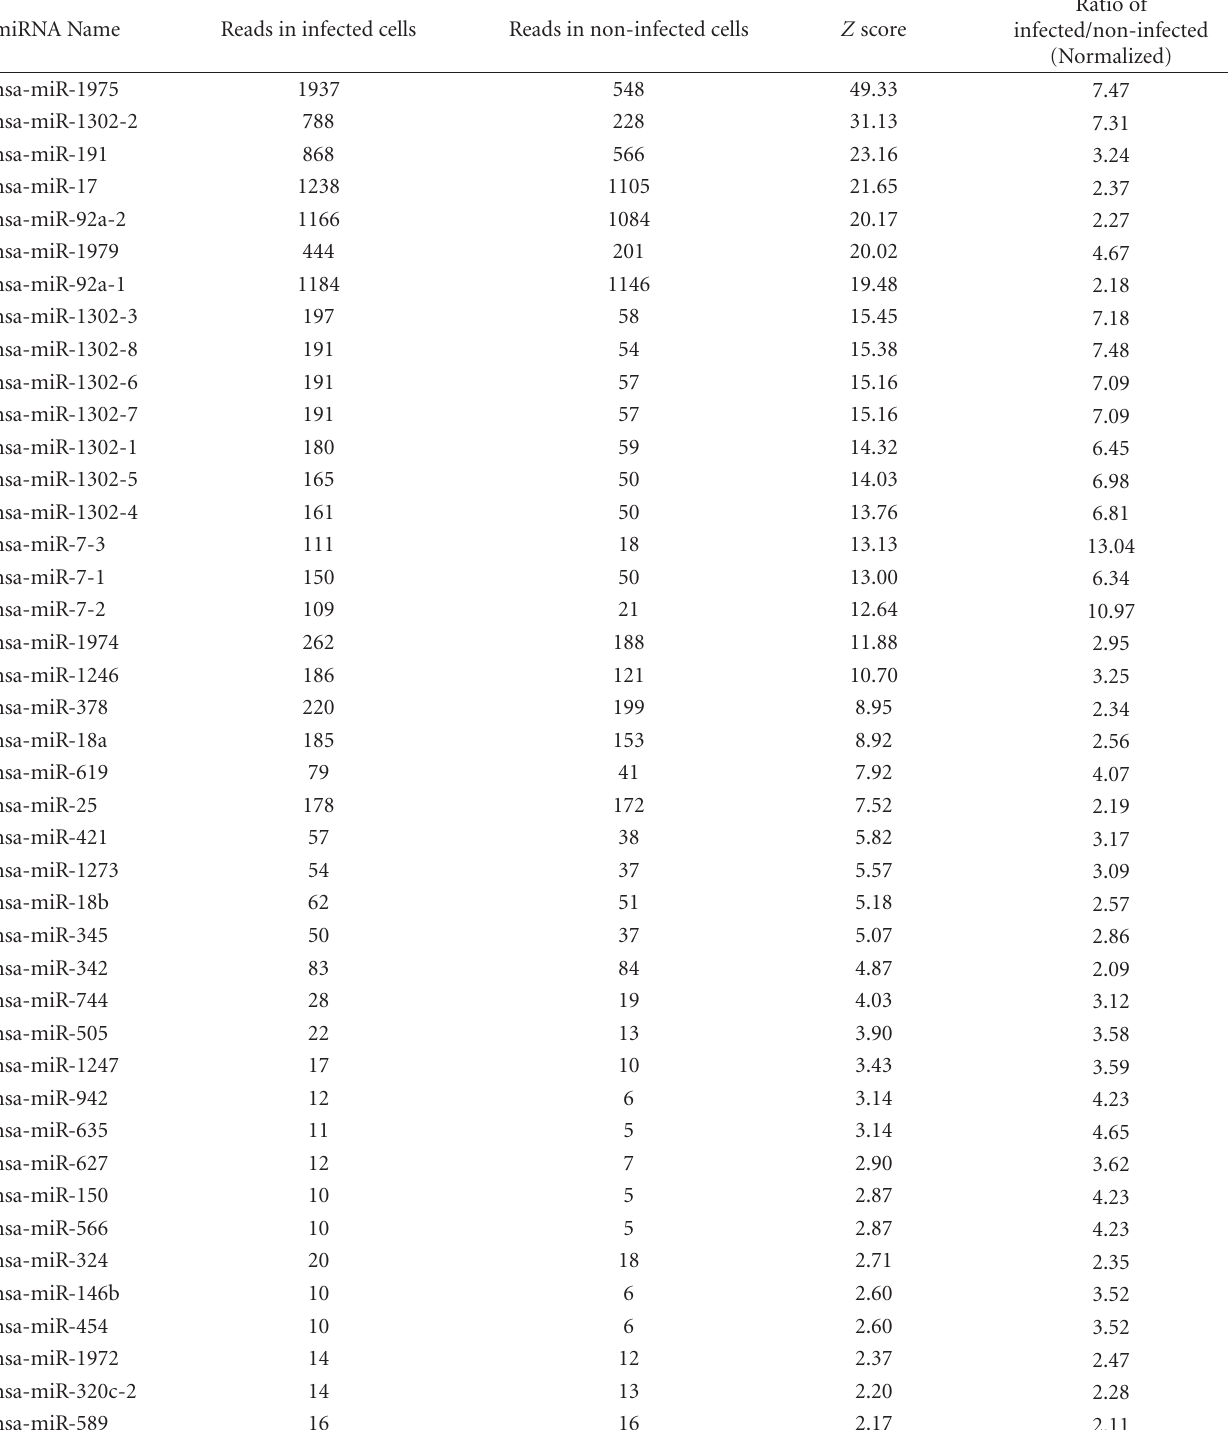
Table 2: Upexpressed miRNAs in infected cells compared with noninfected